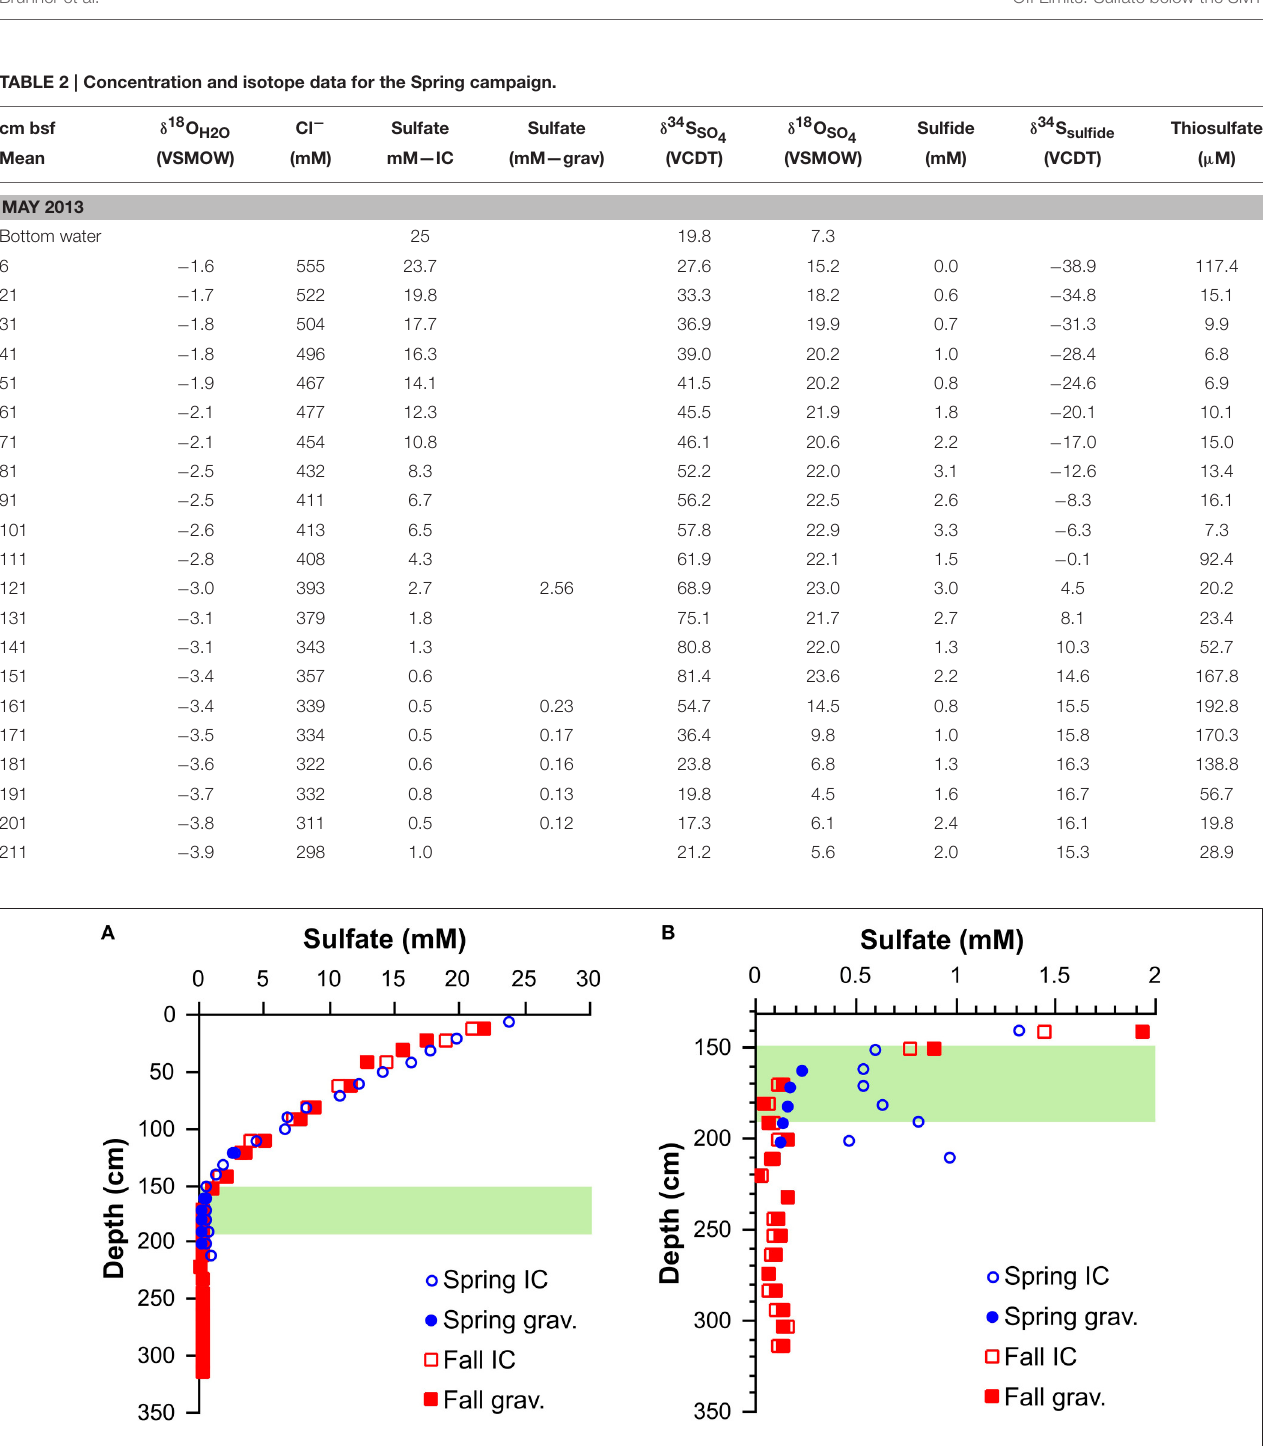
FIGURE 2 | (A) Sulfate concentration profiles for cores from Spring and Fall 2013 and (B) detailed profiles for the low sulfate concentration range. For the Spring core, there is a discrepancy between sulfate concentration measurements by ion chromatographic and gravimetric method. Error on the sulfate concentrations determined by ion chromatography is ± 15% and better than ± 0.02mM by gravimetric method. The green band represents the SMT.